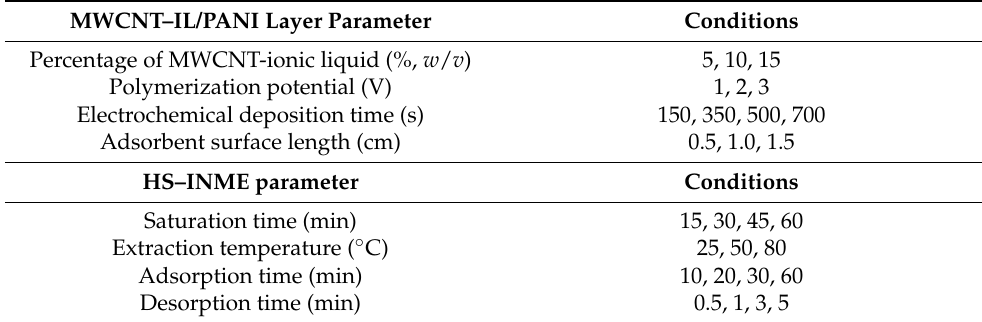
Table 2. The parameters of HS–INME using an MWCNT–IL/PANI-coated stainless-steel wire investigated in this